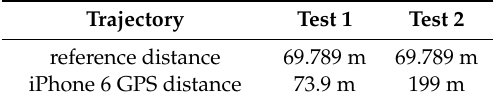
Figure 2. Developed iOS application.